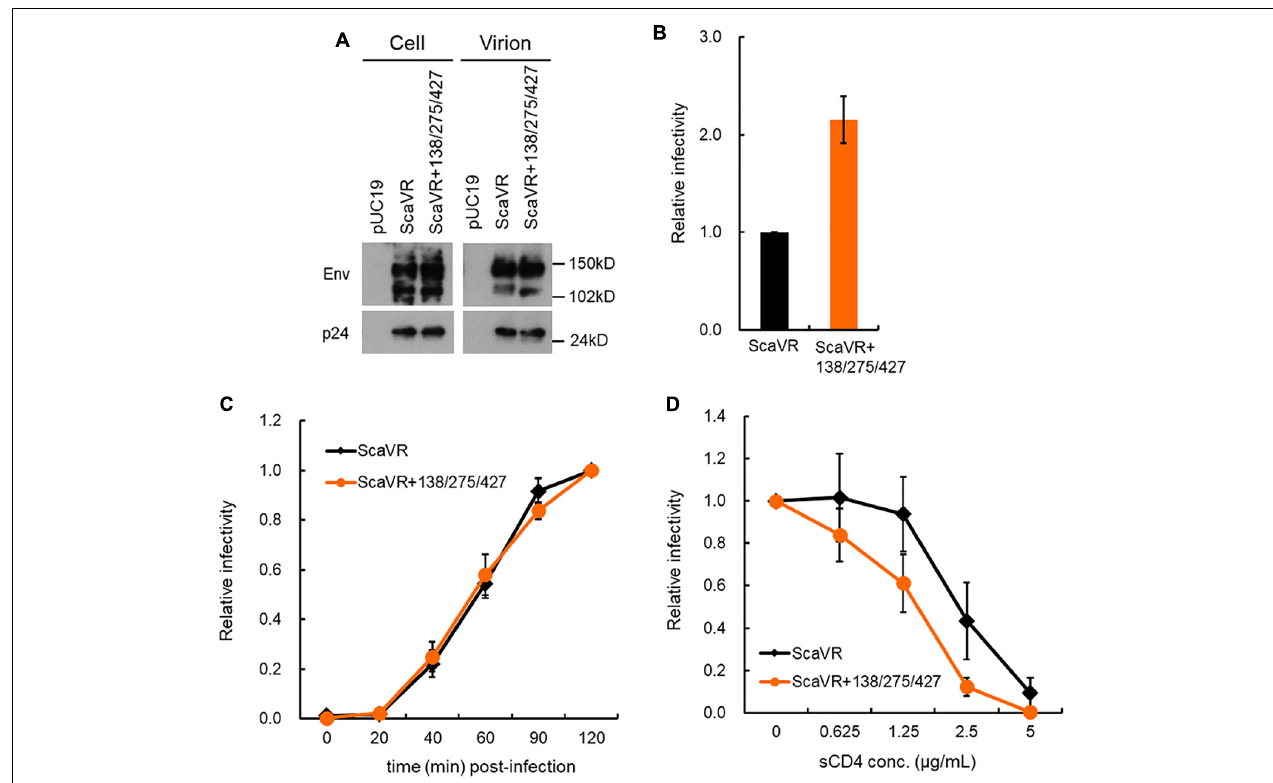
FIGURE 4 | Comparative characterization of ScaVR and ScaVR+138/275/427 viruses. (A) Effect of triple mutations in Env on Env expression level. Lysates were prepared from transfected 293T cells as indicated. Samples containing equal Gag-p24 amounts were analyzed by western blotting using anti-HIV rgp160 and anti-HIV-1 p24 antibodies. Representative data from two independent experiment are shown. (B) Effect of triple mutations in Env on viral infectivity. Viruses prepared from 293T cells transfected with indicated proviral clones were inoculated into TZM-bl cells. On day 2 post-infection, cells were lysed and used for luciferase assays. Viral infectivity is presented as RLU of ScaVR+3 relative to that of ScaVR. Mean values with standard errors (SE) are shown ( n = 6). (C) Effect of triple mutations in Env on entry efficiency. Virus samples prepared from 293T cells transfected with indicated proviral clones were spin-inoculated into TZM-bl cells at 10 ◦ C for 1 h, and were then replaced with pre-warmed fresh media. At indicated time points, AMD3100 was added to culture media at final concentration of 1 µ M. On day 2 post-infection, cells were lysed, and subjected to luciferase assays. Relative infectivity is presented by calculating RLU of each virus sample at the indicated time point relative to that of each virus sample at 120 min post-infection. Mean values ± SE are shown ( n = 4). (D) Effect of triple mutations in Env on sCD4 sensitivity. Viruses were prepared from 293T cells transfected with proviral clones indicated, and were incubated with sCD4 at 37 ◦ C for 1 h. Virus samples were then inoculated into TZM-bl cells, and on day 2 post-infection, cell lysates were prepared for luciferase assays. Relative infectivity, obtained by calculating RLU of each virus sample incubated with sCD4 relative to that of each virus sample incubated without sCD4, is presented. Mean values ± SE are shown ( n =